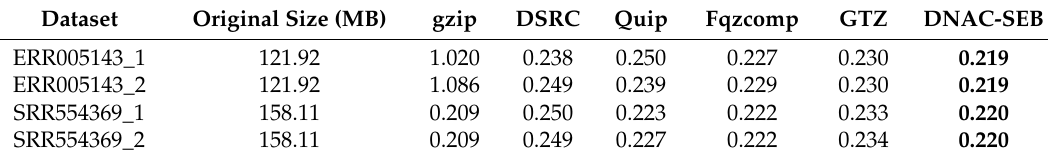
Table 8. Compression ratios of di ff erent tools on 4 FASTQ datasets.